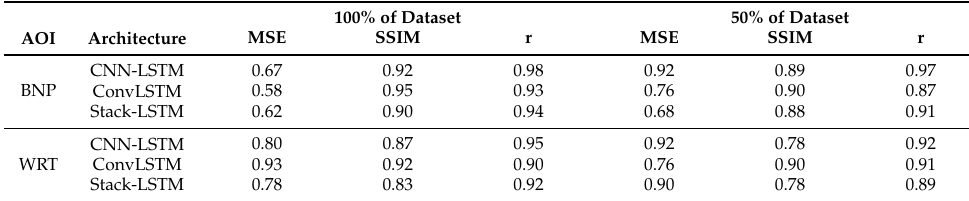
Table 12. Evaluation metrics for CNN-LTSM, ConvLSTM, and Stack-LSTM